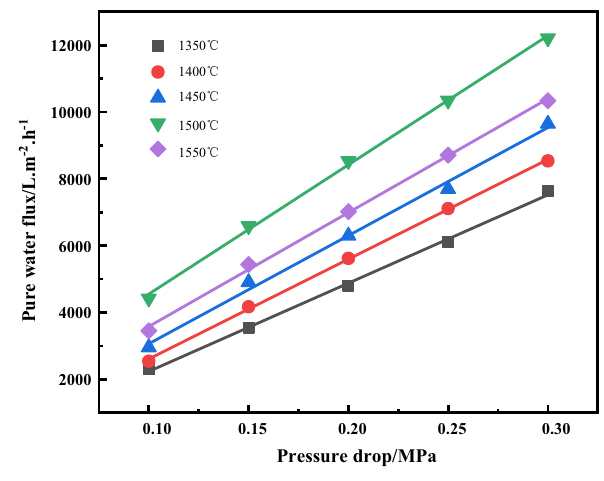
Fig. 8 Relationship between flow rate of pure water volume and oper- ating pressure of samples at different sintering temperatures in the air